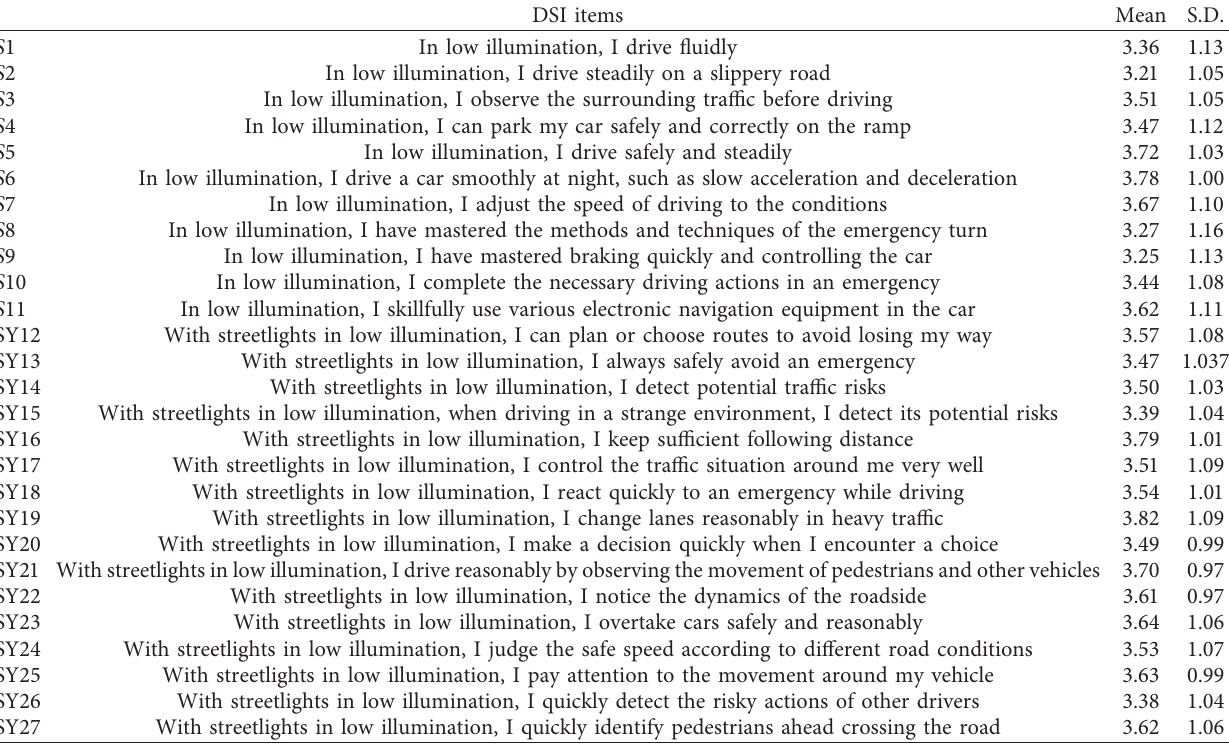
Table 3: Summary of the results for the DSI with streetlights in low illumination.